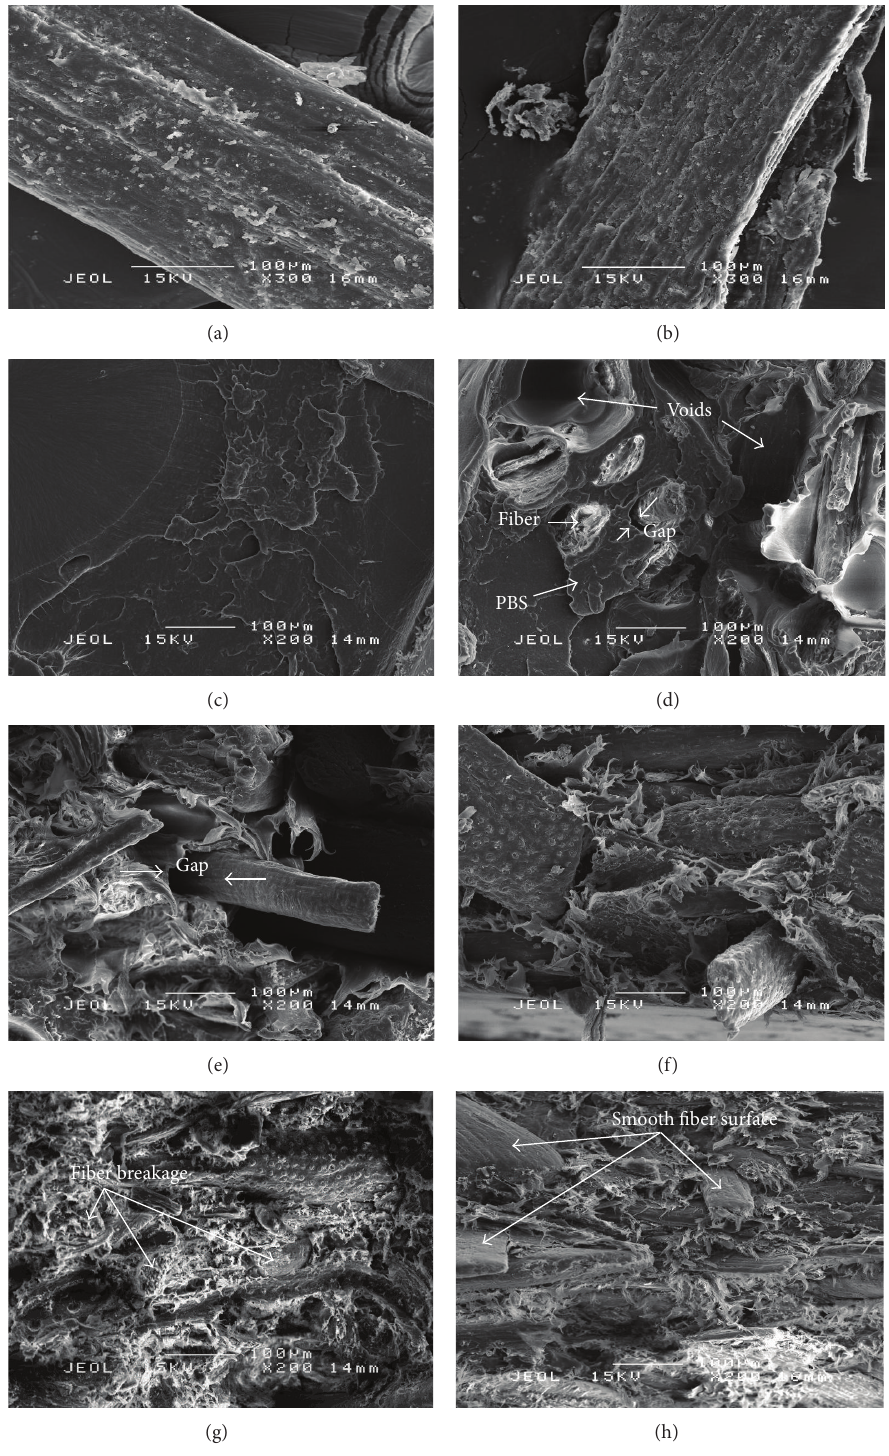
Figure 5: SEM micrographs of (a) OPMF, (b) OPEFBF, (c) PBS, (d) PBS/10 OPMF, (e) PBS/30 OPMF, (f) PBS/50 OPMF, (g) PBS/70 OPMF, and (h) PBS/70